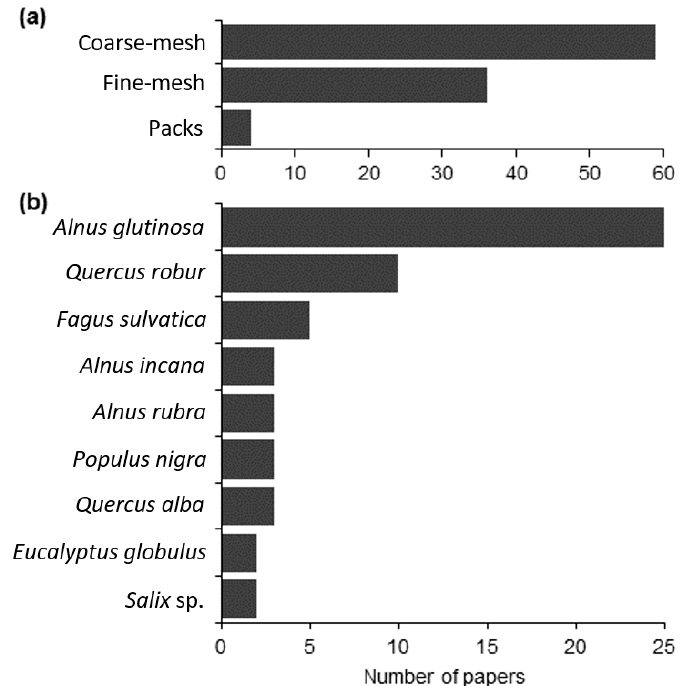
Figure 7. Representation of the ( a ) mesh size (see definitions in Table S1) and ( b ) leaf species in field studies that used leaf litter ( n = 63); only the leaf species used in ≥ 2 studies are shown (a further 28 species were used in 1 study each; Table S3). Several studies used both fine-mesh bags and coarse-mesh bags or packs, and multiple leaf species, and so the sum of the studies across mesh sizes or species surpasses the number of field studies using leaf litter.